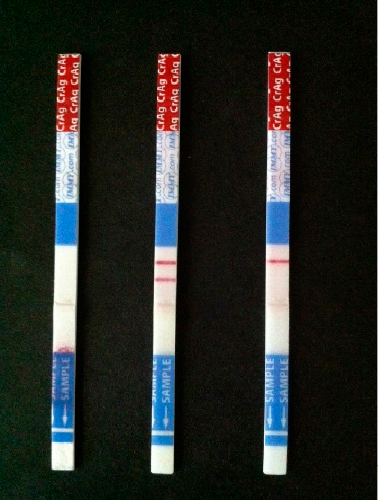
Figure 2. Cryptococcal antigen lateral flow assays (CrAg-LFA).